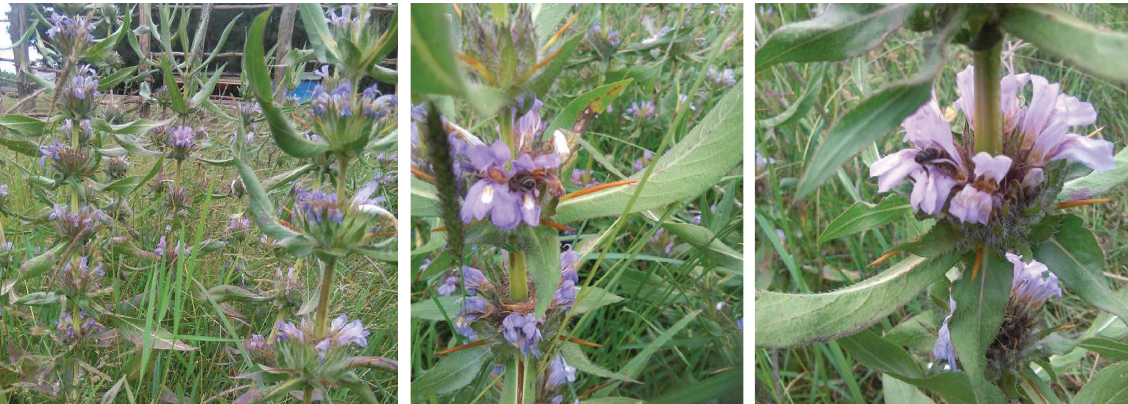
Figure 1: Flowers of H. auriculata and when the honeybees collect nectar.